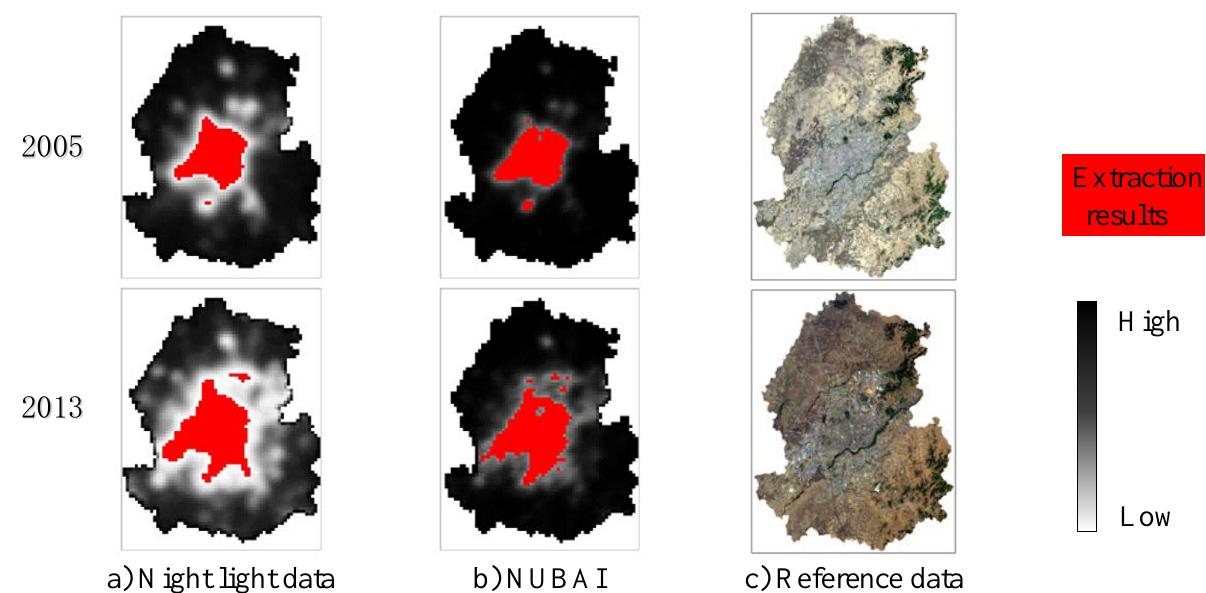
Figure 4. Built-up area extraction results by different variables. ( a ) Night light data; ( b ) NUBAI; ( c ) reference data.